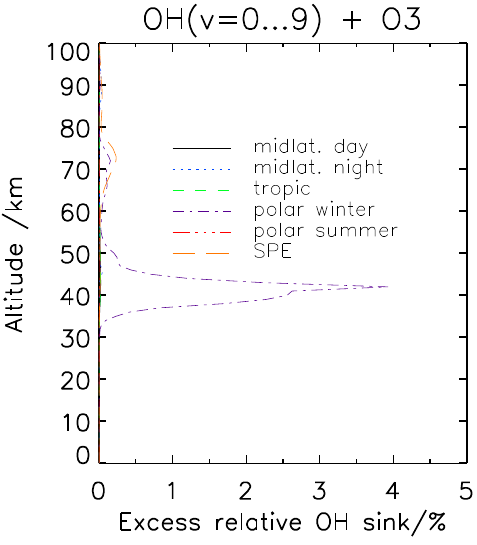
Fig. 8. Excess relative OH sink by consideration of vibrationally excited OH in the OH+O 3 reaction as a function of altitude for var- ious atmospheres.